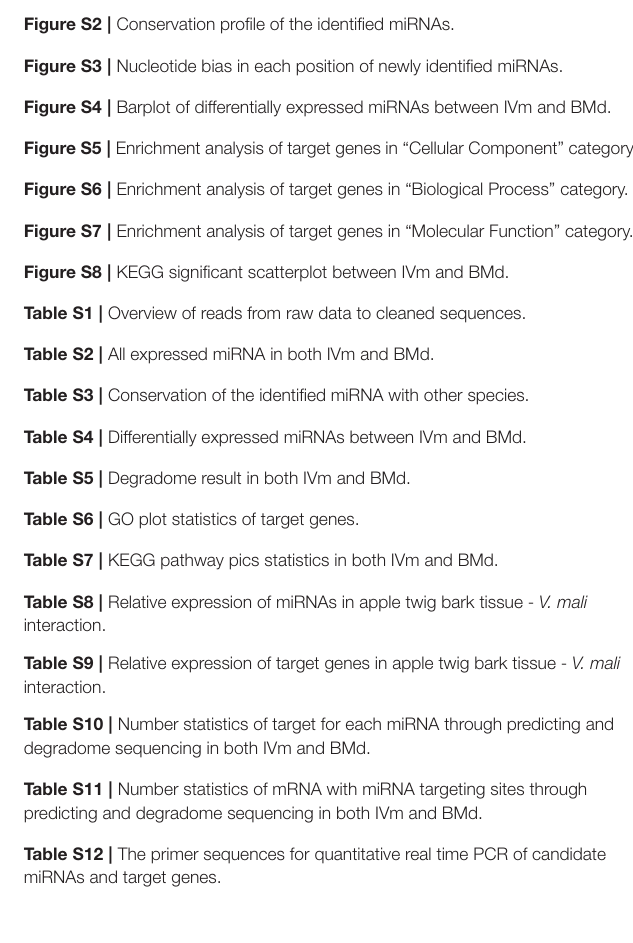
Figure S1 | Rfam sequence category of BMd and IVm. Figure S2 | Conservation profile of the identified miRNAs. Figure S3 | Nucleotide bias in each position of newly identified miRNAs. Figure S4 | Barplot of differentially expressed miRNAs between IVm and BMd. Figure S5 | Enrichment analysis of target genes in “Cellular Component” category. Figure S6 | Enrichment analysis of target genes in “Biological Process” category. Figure S7 | Enrichment analysis of target genes in “Molecular Function” category. Figure S8 | KEGG significant scatterplot between IVm and BMd. Table S1 | Overview of reads from raw data to cleaned sequences. Table S2 | All expressed miRNA in both IVm and BMd. Table S3 | Conservation of the identified miRNA with other species. Table S4 | Differentially expressed miRNAs between IVm and BMd. Table S5 | Degradome result in both IVm and BMd. Table S6 | GO plot statistics of target